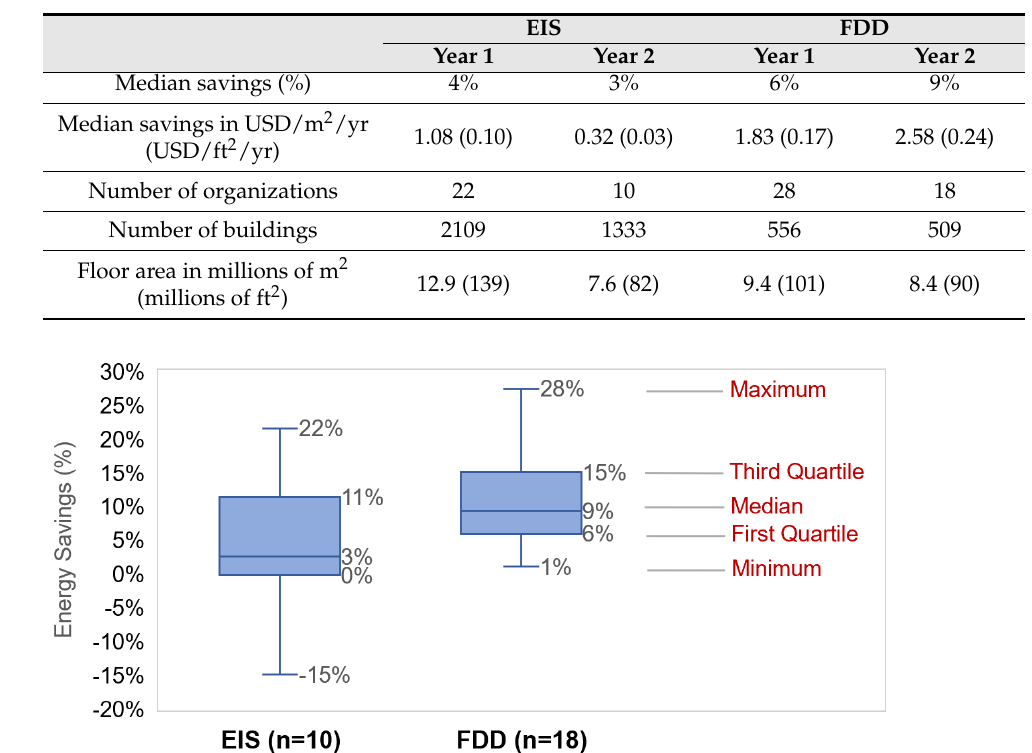
Table 3. The second-year energy savings distributions by building sector.